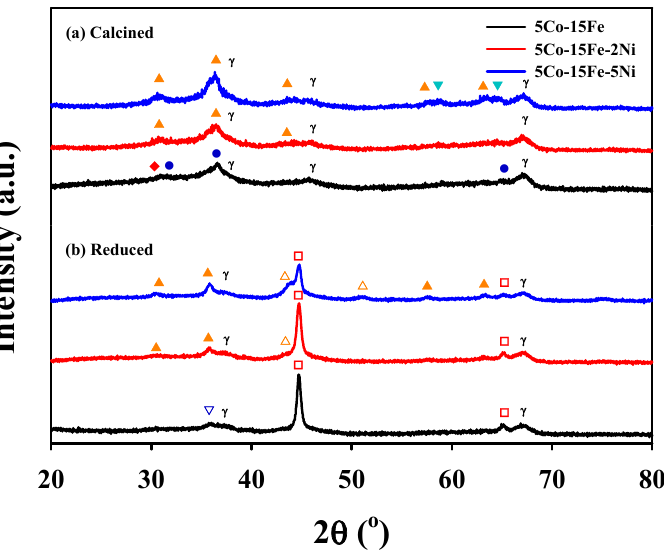
Figure 4. XRD patterns of the ( a ) calcined and ( b ) reduced Co-Fe and Co-Fe-Ni catalysts; ( γ ) γ -Al 2 O 3 , ( ◆ ) Fe 2 O 3 , ( □ ) Fe metal, ( ● ) Co 3 O 4 , ( ▽ ) CoO, ( ▼ ) NiCo 2 O 4 ( ▲ ) NiFe 2 O 4 , and ( △ ) Ni-Fe alloy.